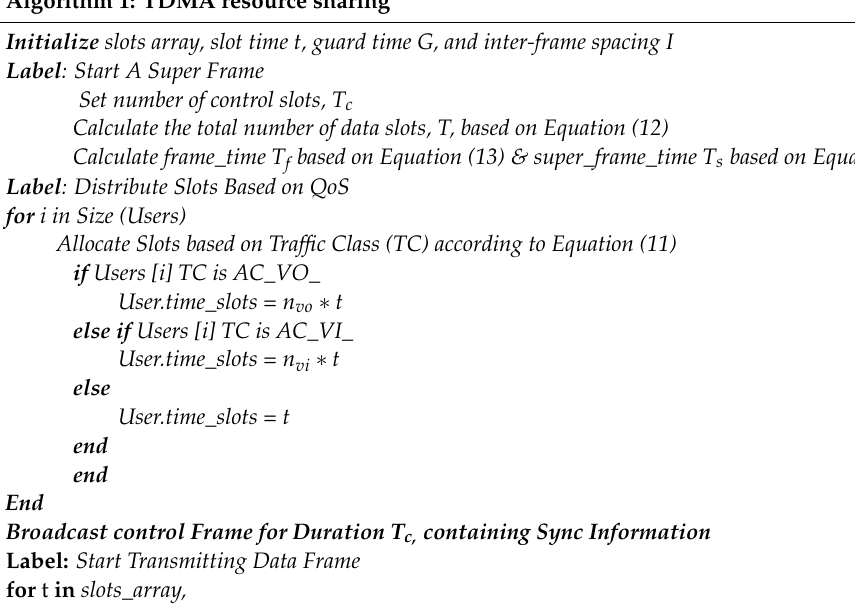
Algorithm 1: TDMA resource